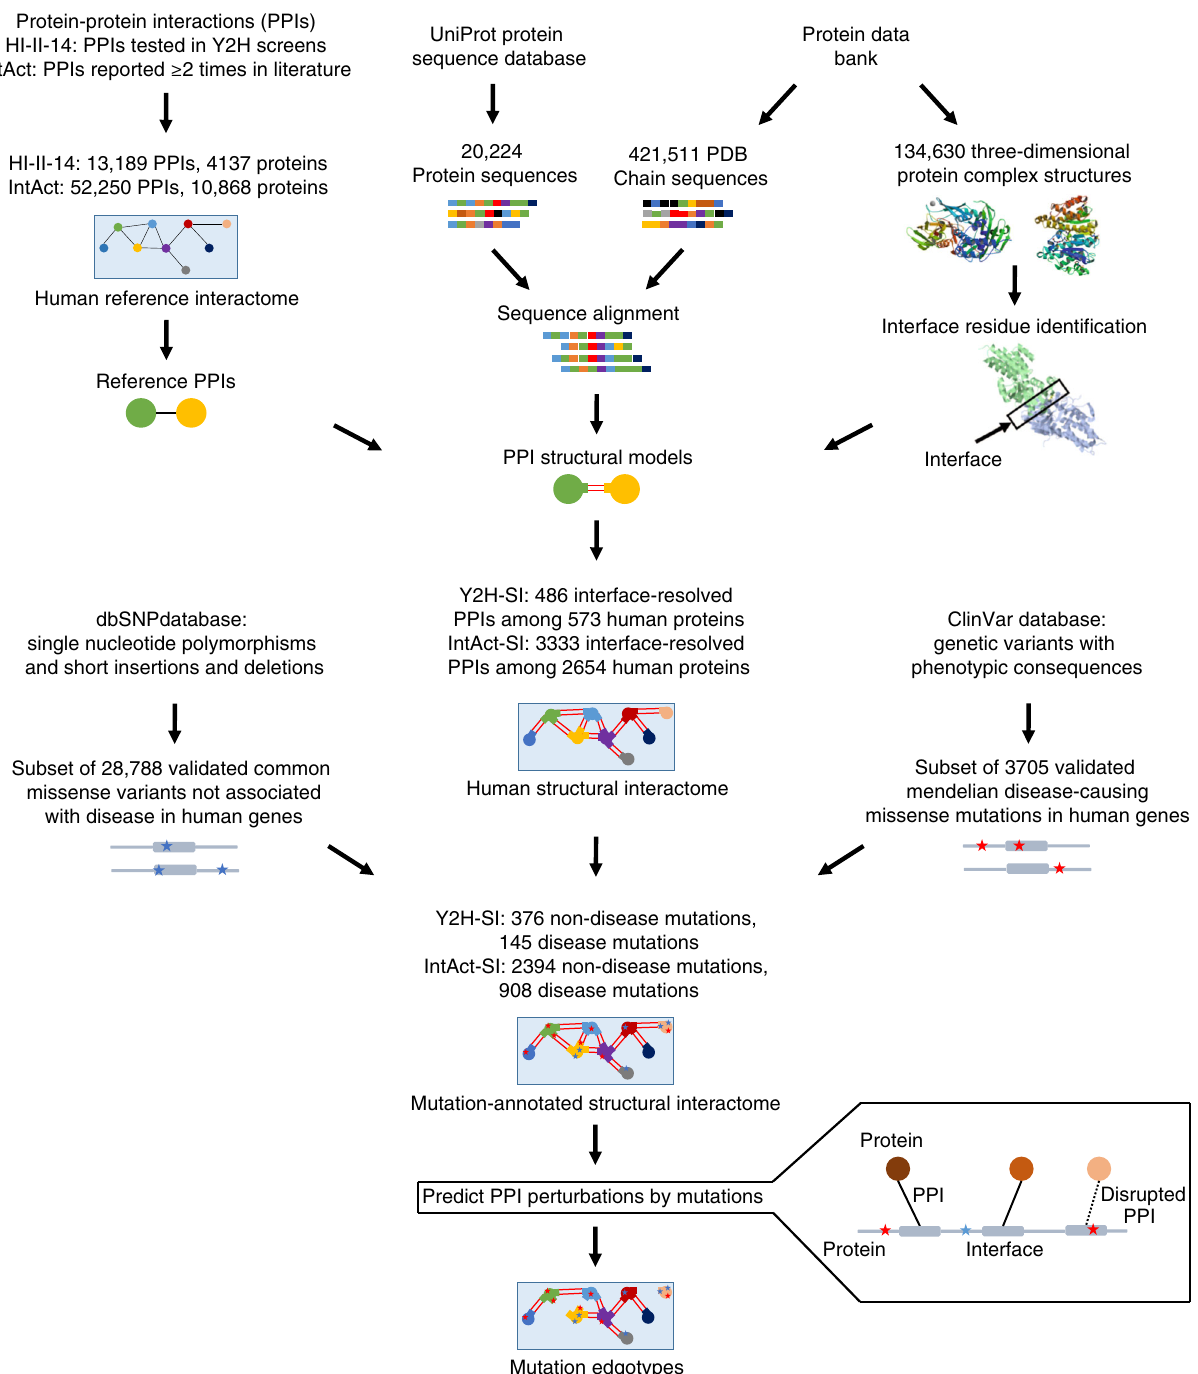
Fig. 1 Pipeline for the computational prediction of mutation edgotypes. Computational pipeline used for construction of the human structural interactomes (Y2H-SI and IntAct-SI) from the human reference interactomes (HI-II-14 and IntAct) and subsequent prediction of mutation-induced interactome perturbations and mutation